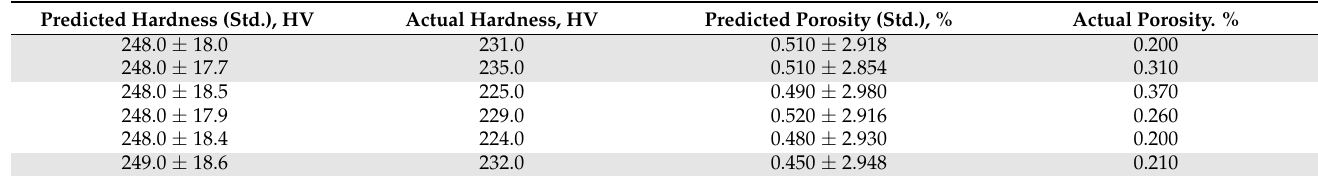
Table 5. Predicted versus actual target variables. Highlighted rows indicate the Pareto front. Predicted Hardness (Std.), HV Actual Hardness,